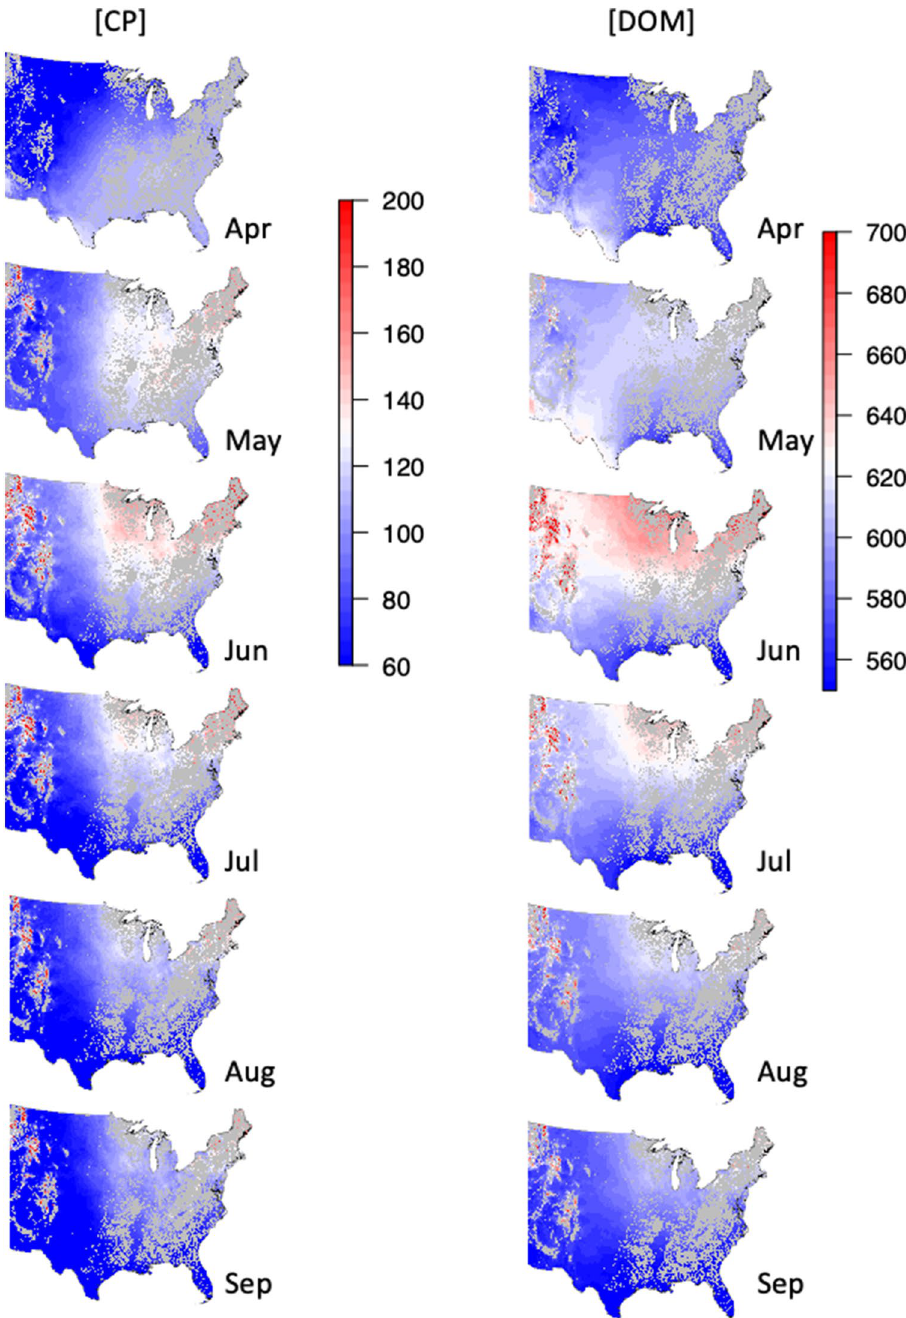
Figure 4. Maps of dietary crude protein and digestible organic matter concentrations for non-forested areas. Maps are modeled based on Supplementary Table S3. Units are mg g −1 . Maps generated utilizing the raster package for reclassifying and masking pixels in R